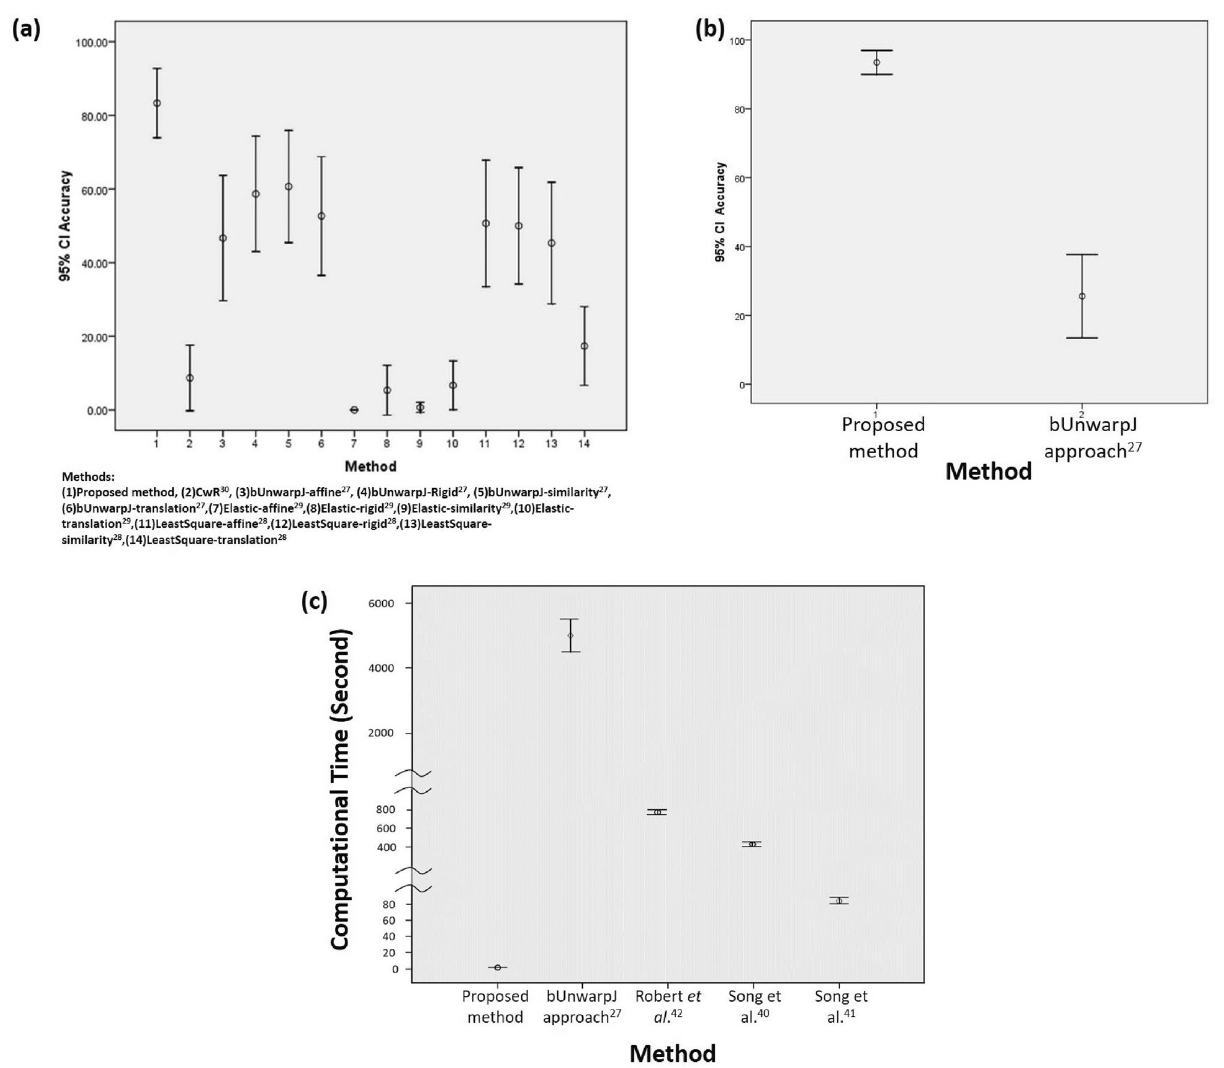
Figure 4. ( a ) Evaluation results on the triple staining prostate cancer slides by the proposed method and benchmark approaches 7–10 . ( b ) Evaluation results on the dual staining breast cancer slides by the proposed method and the best performed benchmark approach in the first experiment 7 . ( c ) Run time analysis in cross- staining WSI registration of the proposed method and benchmark approaches 7,27,28,47